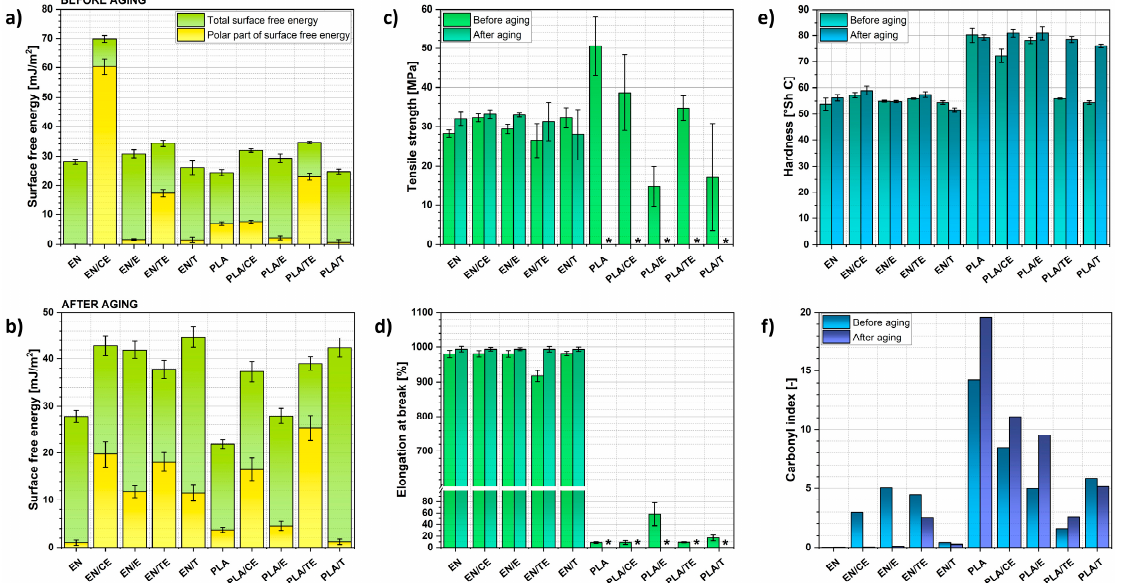
Figure 7. Representation of how different properties have changed during the solar aging of materials: total surface free energy and its polar component before ( a ) and after ( b ) the aging process, tensile strength ( c ), elongation at break ( d ), hardness ( e ), as well as carbonyl index calculated based on the data derived from FT-IR spectra ( f ). ∗ —the measurement was unable to be performed as the polymer sample exhibited significant brittleness.